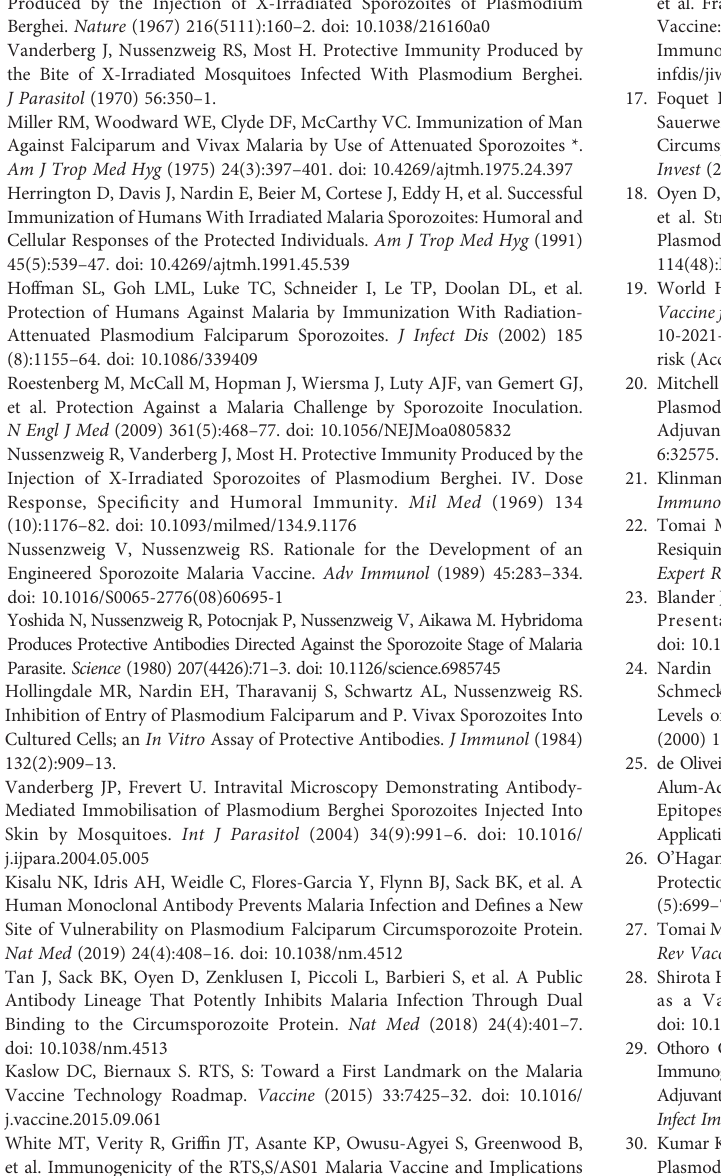
Supplementary Figure 2 | Scoring of IHC-labeled skin obtained 24h post SS prime. Following IHC labeling of skin, the area under the SS site (outline) was examined by microscopy for cellular in fi ltration. The intensity of cellular in fi ltration was scored as: 1+, scattered positive cells; 2+, cellular staining localized to SS site; 3+, increased cellular in fi ltration localized to SS site; 4+ heavy cellular in fi ltration at SS site. Supplementary Figure 3 | IL-22 in serum of IP-10 -/- and WT mice post SS prime. ELISA quantitation of IL-22 (pg/ml) in serum of IP-10 -/- (purple bars) as